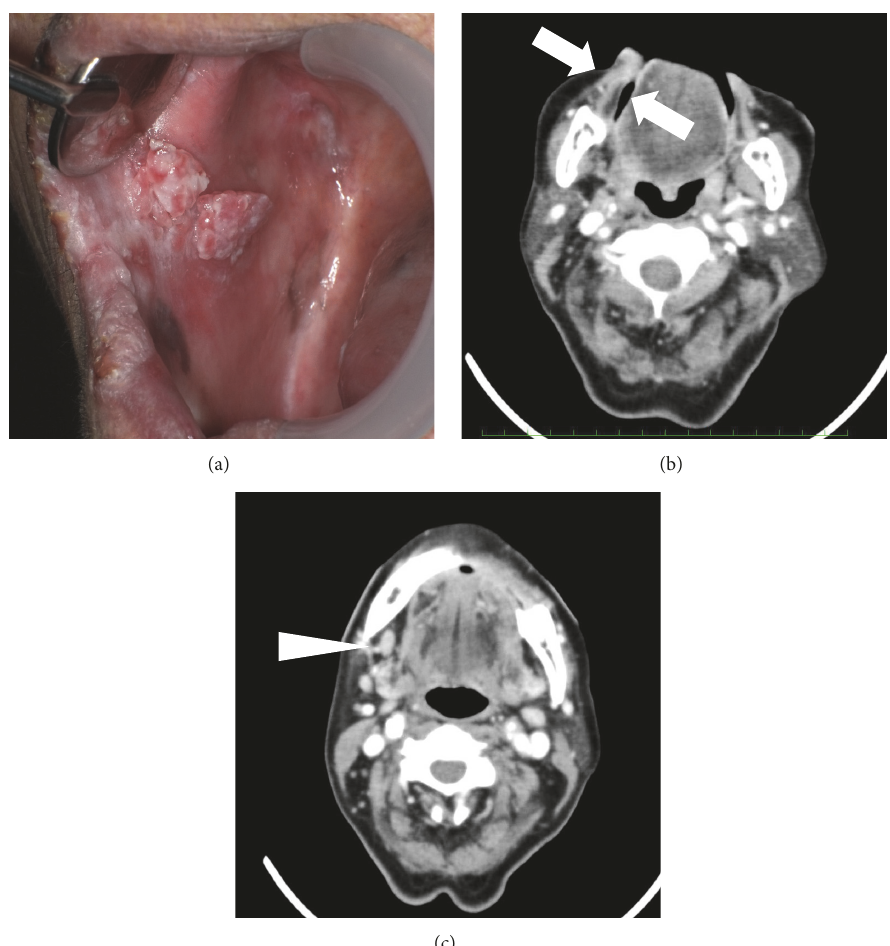
Figure 2: Intraoral findings at most recent follow-up . Intraoral findings (a) and CT images of the right buccal region (b, arrow) and submandibular lymph node (c, arrow